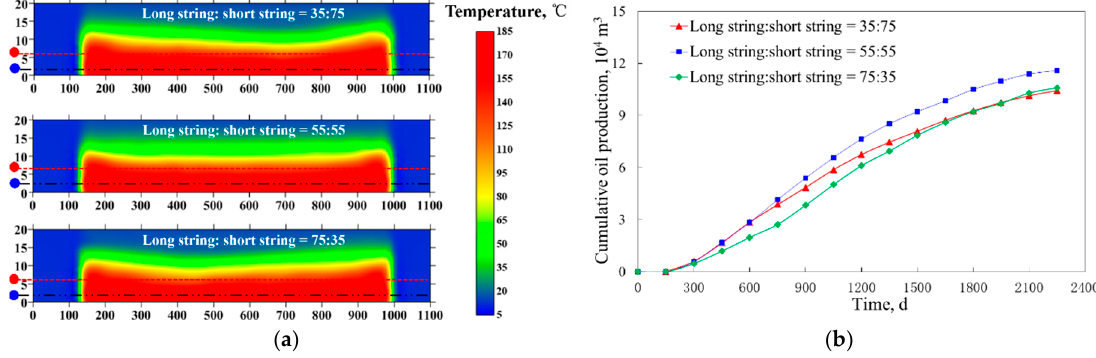
Figure 14. Effect of the steam injection ratio on the steam chamber and cumulative oil production: ( a ) steam chamber; ( b ) cumulative oil production.